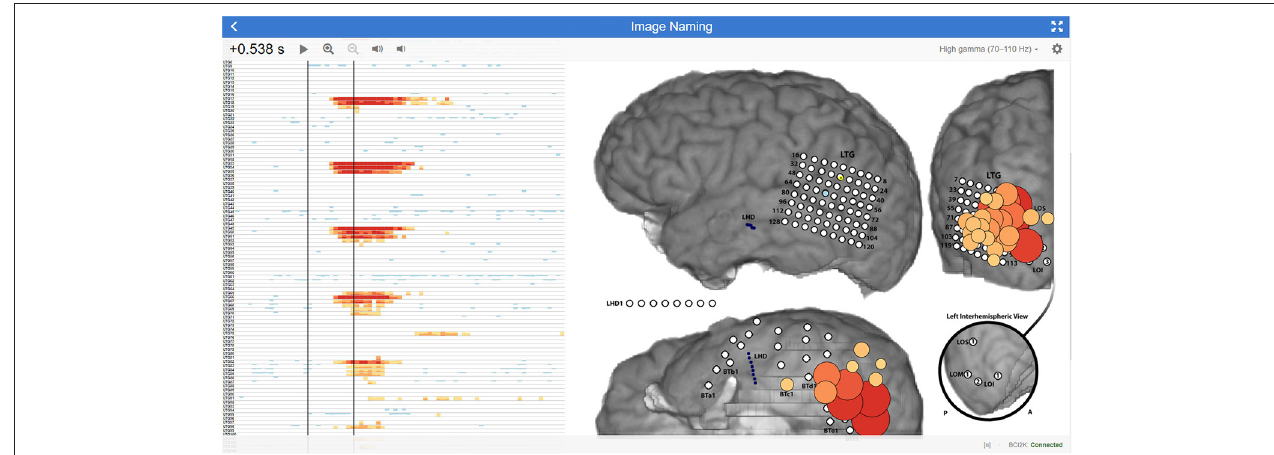
FIGURE 4 | WebFM visualization description An example of WebFM results for an image naming task in a subject with high density (5-mm spacing) temporal-parietal-occipital electrode coverage. A horizon raster Heer et al. (2009) to the left shows a time ( x -axis) by channels ( y -axis) plot of trial-averaged task-modulated high gamma power, thresholded for statistical significance with BH correction for a FDR of < 0.05. Warm colors represent a statistically significant increase in task-modulated high gamma power, while cool colors indicate a statistically significant decrease in task-modulated high gamma power. The left black vertical bar within the raster indicates the trial-start ( t = 0 s) where StimulusCode transitioned from zero to a non-zero value, indicating that a stimulus was being displayed. The right black vertical bar is a temporal cursor that interactively tracks the user’s mouse gestures; the current time it indexes is shown in the top left corner, 0.538 s after stimulus onset. Buttons next to the selected time manipulate visualization properties. The current temporal slice is visualized on the brain image (right) as circles with size and color indicating the magnitude of the z -score, with the same coloration as in the horizon chart. A button in the top right maximizes the display to occupy the full screen-space of the device; a gear icon next to the fullscreen icon presents a configuration dialog box containing options for saving results, changing visualization parameters, configuring realtime signal or BCI2000 state trial-triggering, and visualizing the raw signal, amongst much more functionality. A drop down menu next to the gear icon turns on/off multiple visualization layers, enabling/disabling display of ESM, functional mapping, connectivity metrics, evoked responses, etc. A status message at the bottom right indicates WebFM has connected to BCI2000Web via bci2k.js and a trial counter, in this image represented with an “[n]”, increments as trials are delivered to and visualized by